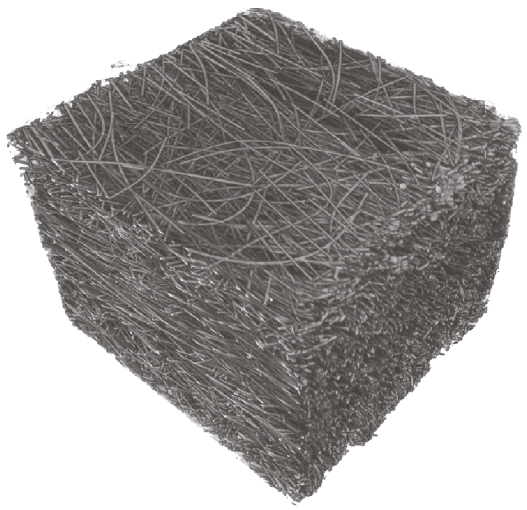
Figure 1: CT scan of a LFRP component with an isotropic voxel size of 4 . 36 μ m.